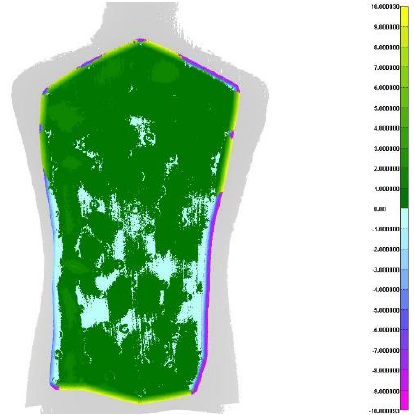
Figure 12 Deviation map between NextEngine 3D model and